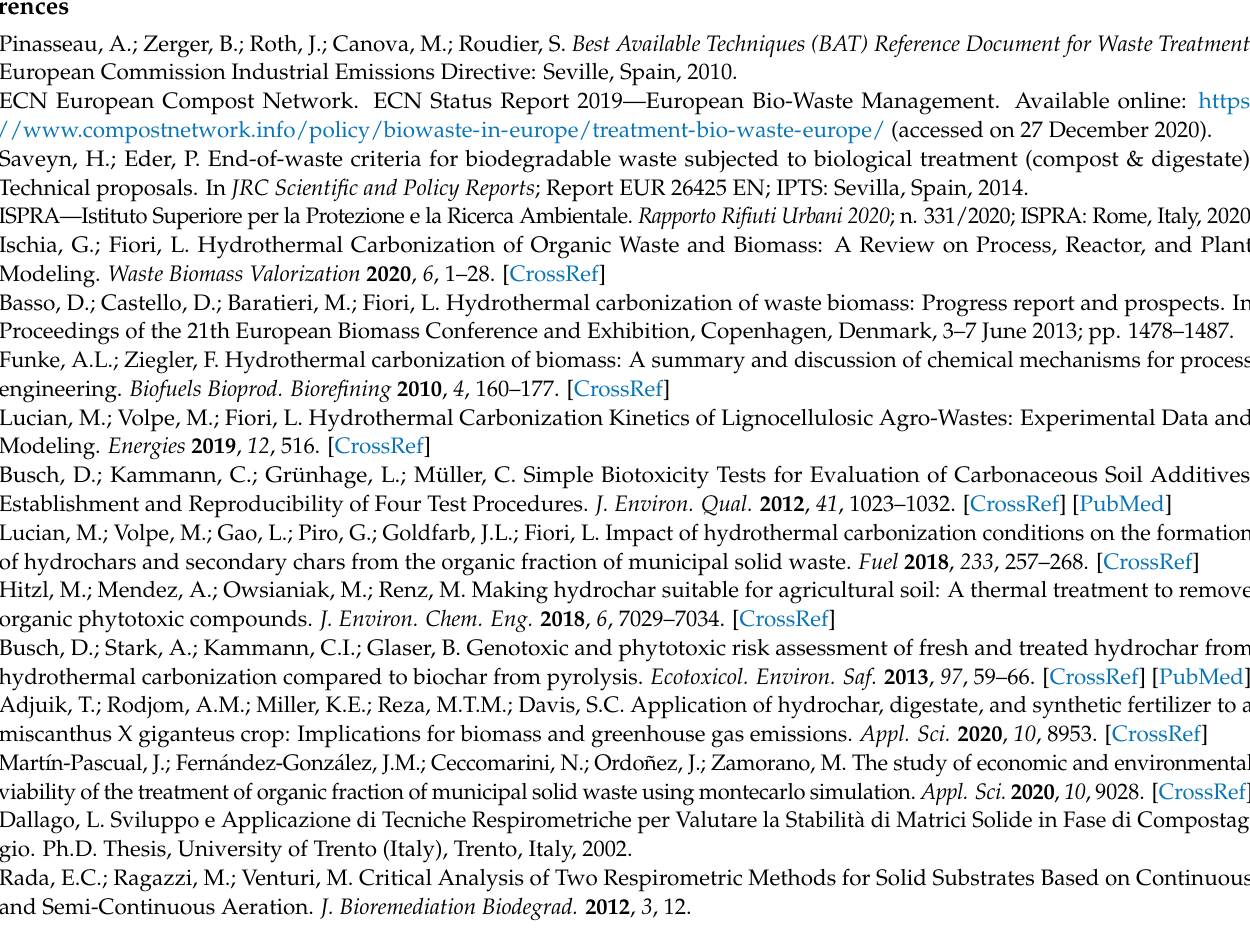
Figure A4. The final curve of the DRI for the MIX 25% after the calculation process using Matlab ® . All the DRI curves are superposed in Figure 8.